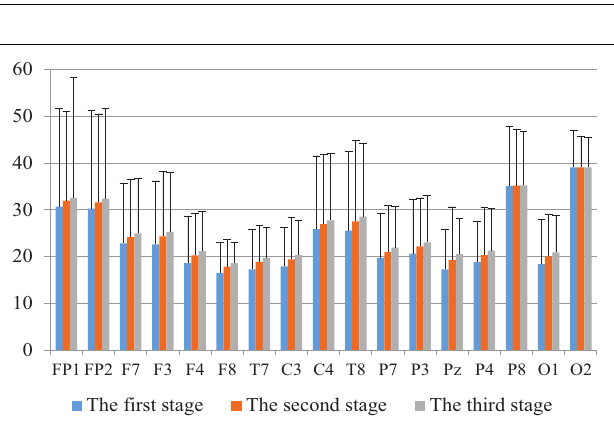
FIGURE 5 | The characteristics of theta wave power changes in whole brain regions of healthy subjects in the three experimental stages.